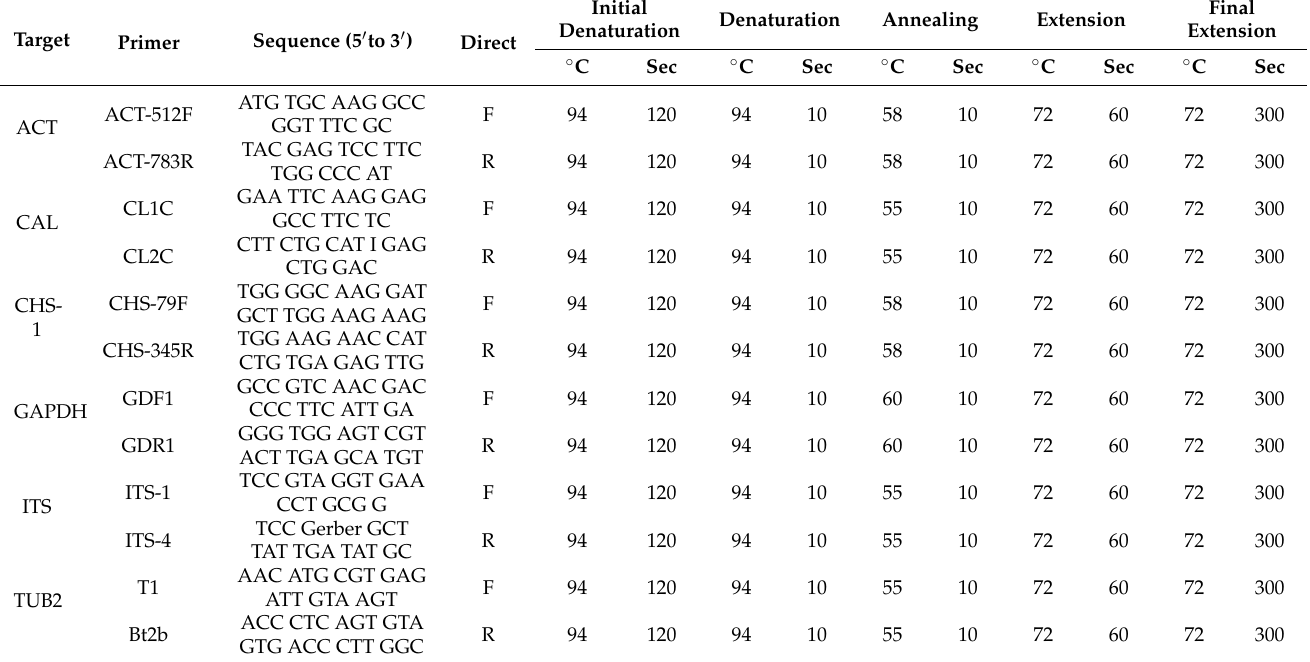
Table 1. Primer information used in this study and PCR reaction